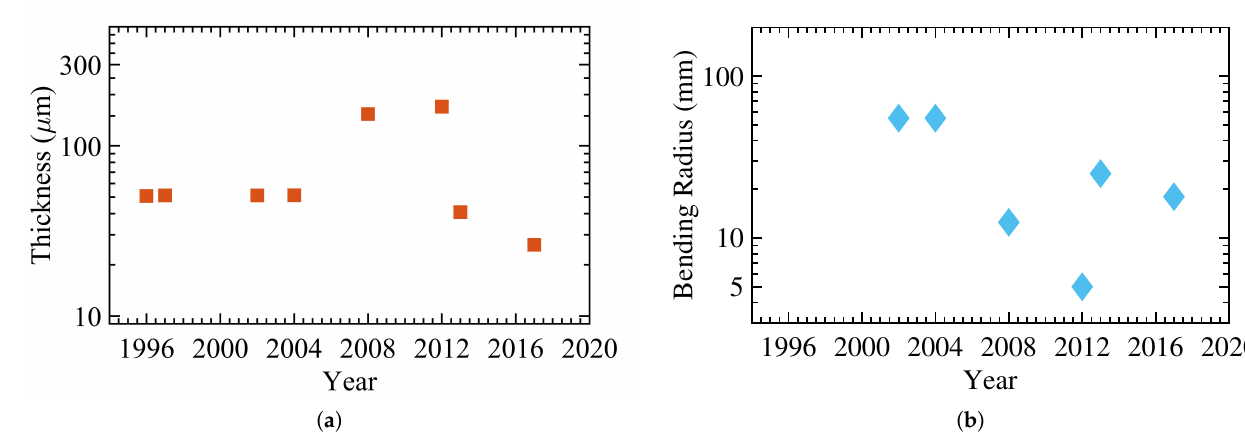
Figure 3. The progress of hydrogenated amorphous silicon (a-Si:H) Thin-Film Transistors (TFTs) with ( a ) the total thickness and ( b ) the bending radius.